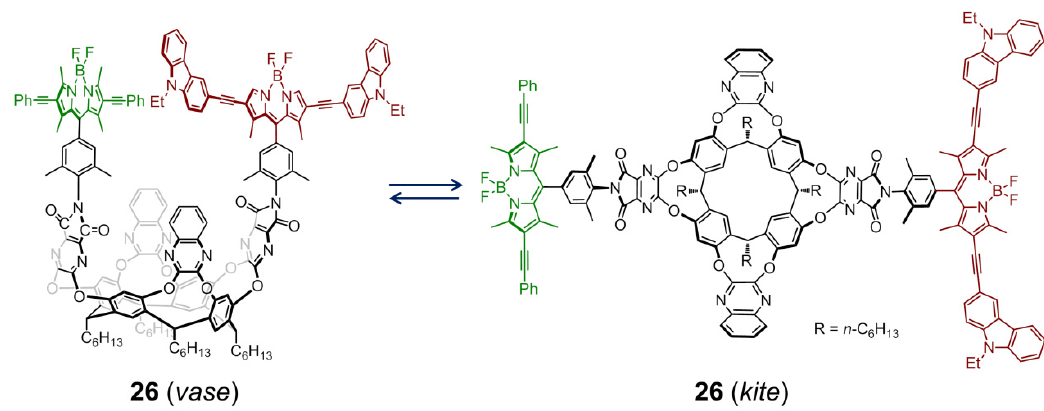
Figure 17. Chemical structure of BODIPY-decorated resorcin[4]arenes 26 and its vase -to- kite conformation